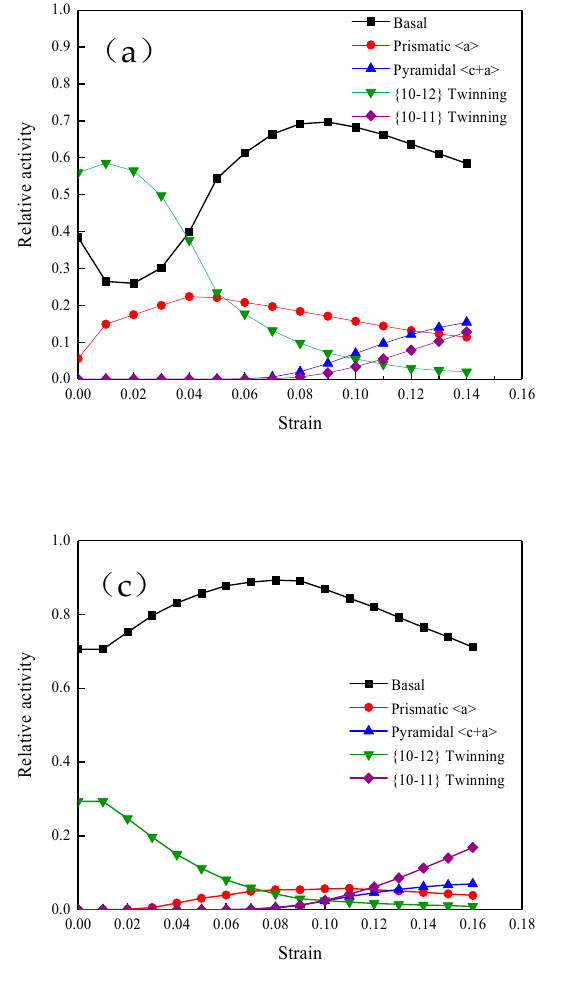
Figure 6. Predicted relative activity of different deformation modes under uniaxial compression along the ( a ) ED, ( b ) 45ED, and ( c ) PED.